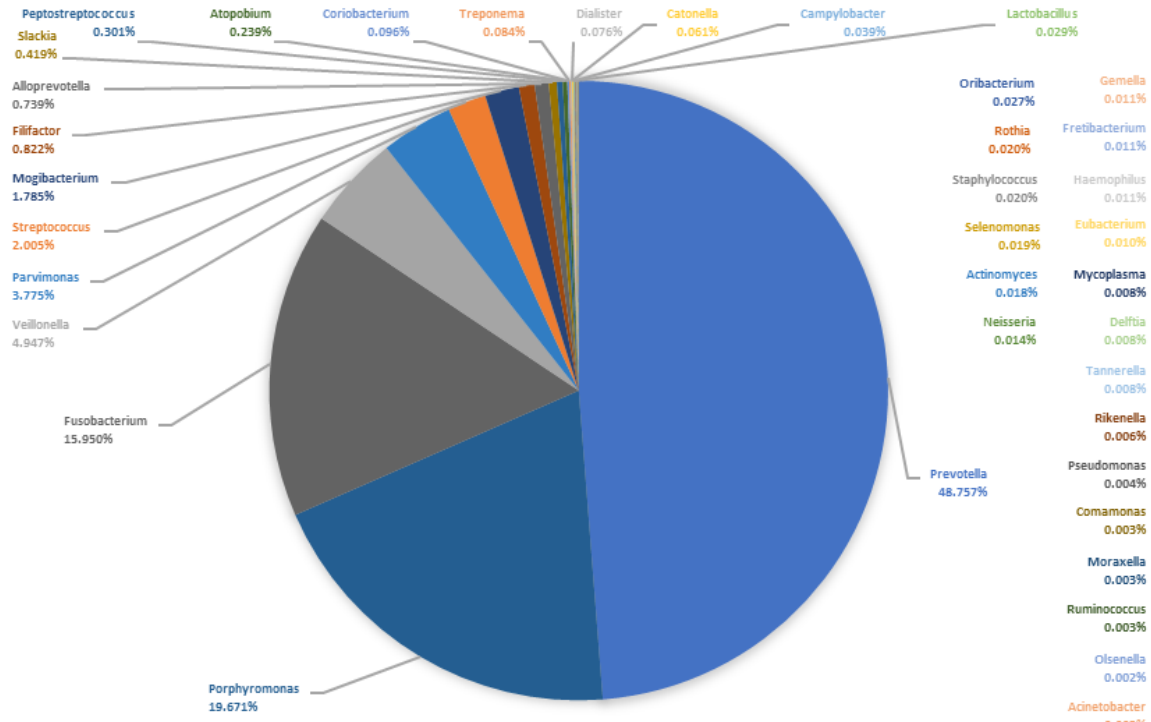
Figure 5. Median microbiome of all saliva samples ( n = 50). The pie chart shows the proportion of the bacterial genera of the sum of all medians of the relative abundances.